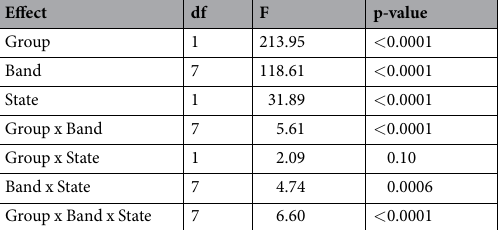
Table 2. A 3-way ANOVA was performed on Fisher’s z-transformed correlation coefficients with the between- subject factor Group (Monozygotic, Dizygotic, Non-Related, Self) and within-subject factors Band (Delta, Theta, Alpha, Sigma, Beta 1, Beta 2, Gamma 1, Gamma 2) and State (NREMS, REMS). The factors Group, Band and State were significant, as well as all their interactions with the exception of Group x State. The total number of degrees of freedom (df) was